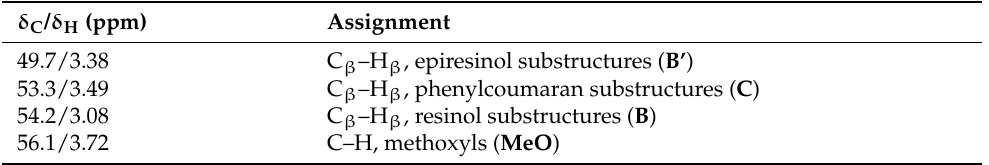
Figure 6. Main lignin substructures identified in aromatic region of orange and olive soda/AQ lignins: ( FA ), ferulate; ( G ), guaiacyl unit; ( G ’), vanillin; ( G” ), acetovanillona; ( G”’ ), vanillic acid; ( H ), p-hydroxyphenyl unit; ( J ), cinnamyl aldehyde end-groups; ( S ), syringyl unit; ( S’ ), syringaldehyde or acetosyringone; ( SB1 ), stilbene- β -1’; ( SB5 ), stilbene- β -5’; ( V ), vinyl ether. Table 1. Assignment of main lignin and carbohydrates 13 C- 1 H correlation peaks in the HSQC spectra of soda/AQ lignins.